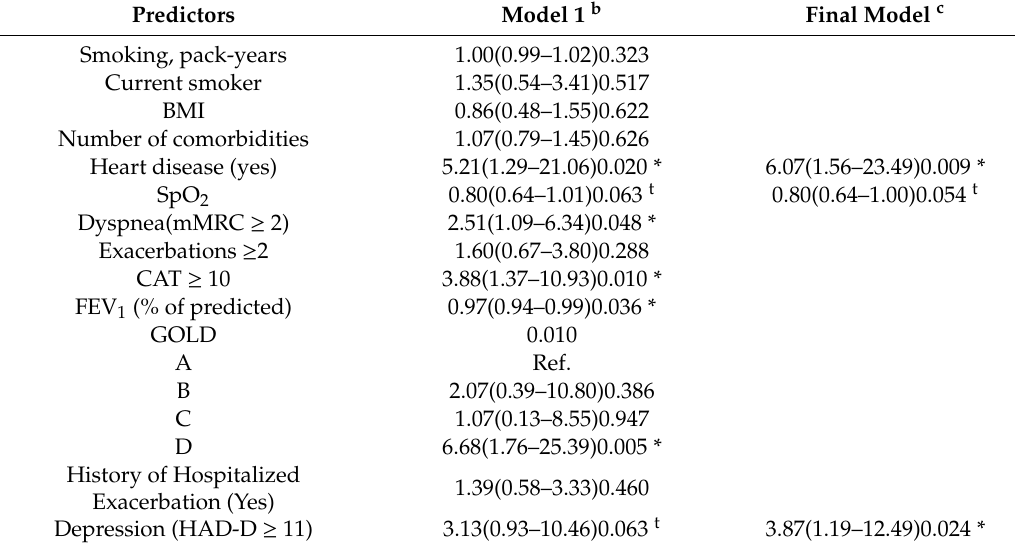
Table 2. Multivariate regression models show the predictive strengths of clinical and pulmonary factors for poor 6MWT performance (<350 m) a .